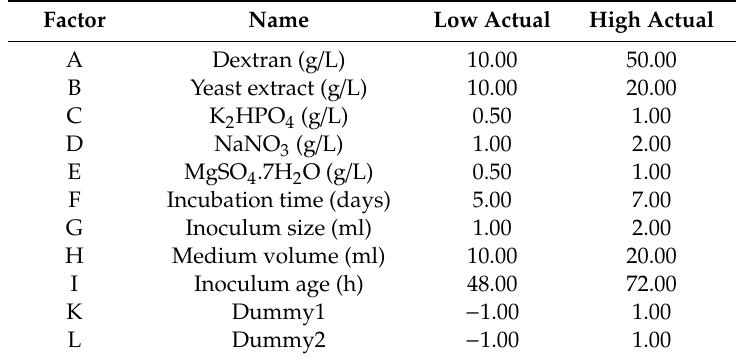
Table 6. Plackett-Burman (PB) design for dextranase production by P. roquefortii TISTR